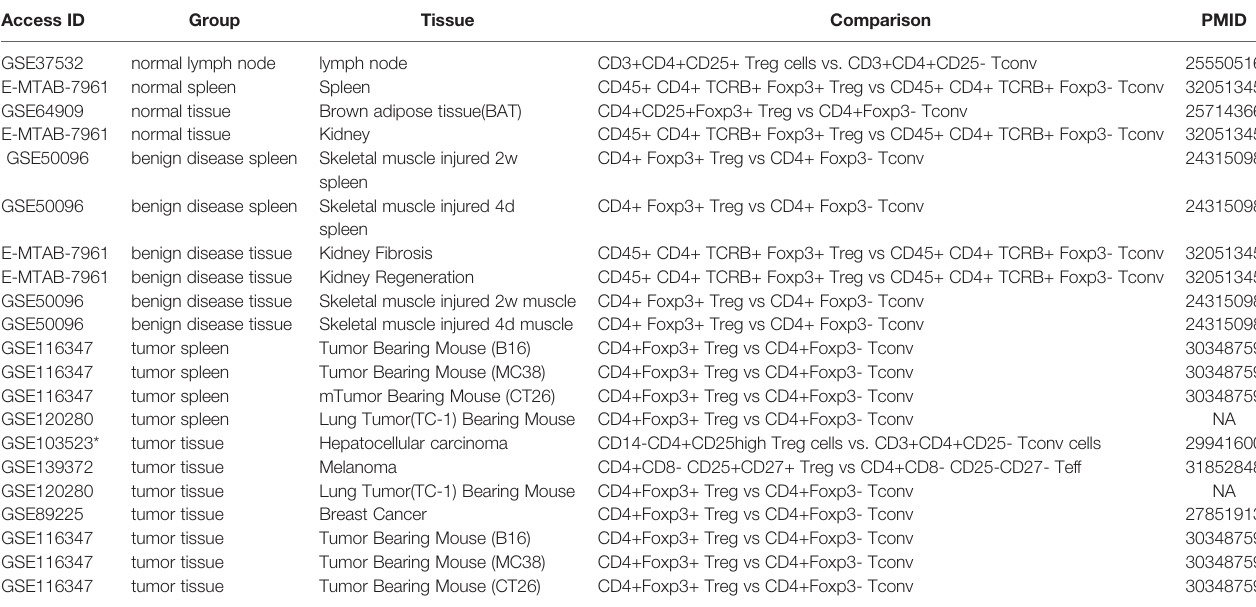
TABLE 1 | Twenty-three Treg transcriptomic datasets collected from the NIH-NCBI-GEO and EMBL-EBI databases were analyzed. Access ID